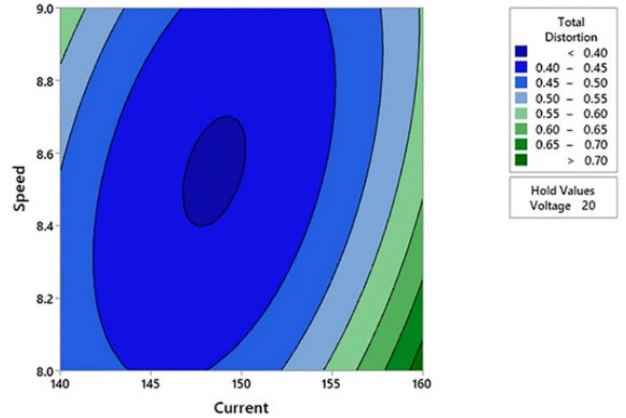
Figure 8. Contour Plot of Distortion vs. Current, Speed.